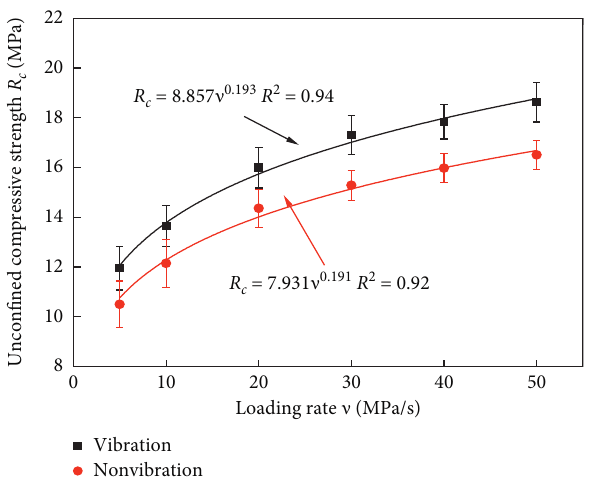
Figure 4: Unconfined compressive strength of cement-treated aggregates affected by loading rates.